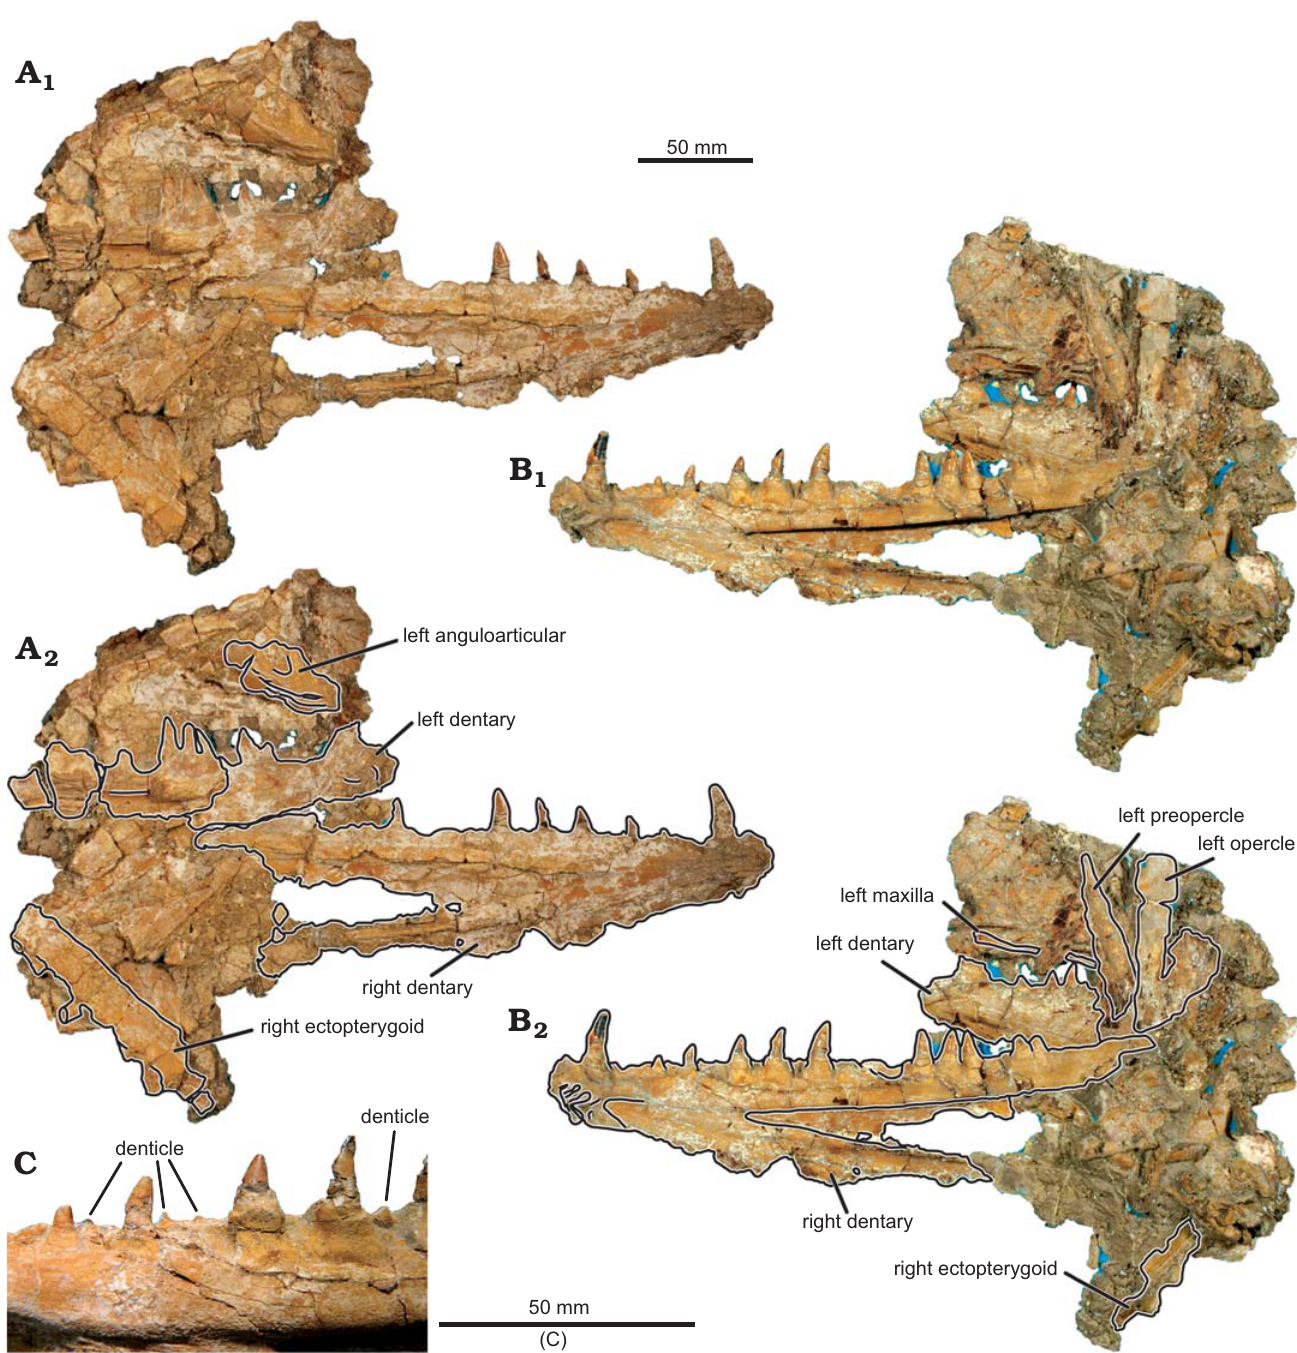
Fig. 2. Aulopiform teleost Enchodus tineidae sp. nov. holotype (MUVP 59) from the Campanian of central Egypt. A , B . Photographs of specimen in lateral (A 1 ) and medial (B 1 ) views; photographs with identifiable elements outlined, in lateral (A 2 ) and medial (B 2 ) views. C . Close up of denticles of the lateral tooth